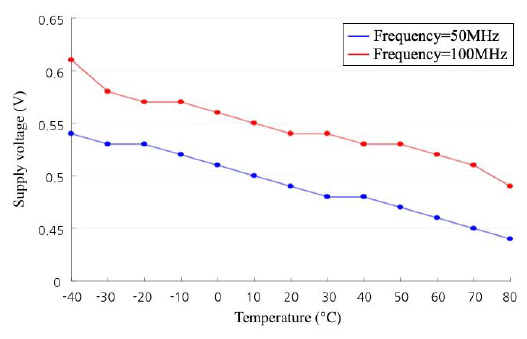
Figure 3. Minimum supply voltage by temperature, measured from the